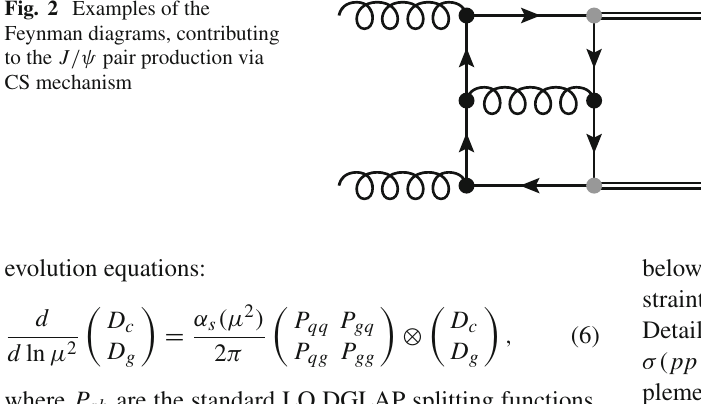
Fig. 2 Examples of the Feynman diagrams, contributing to the J /ψ pair production via CS